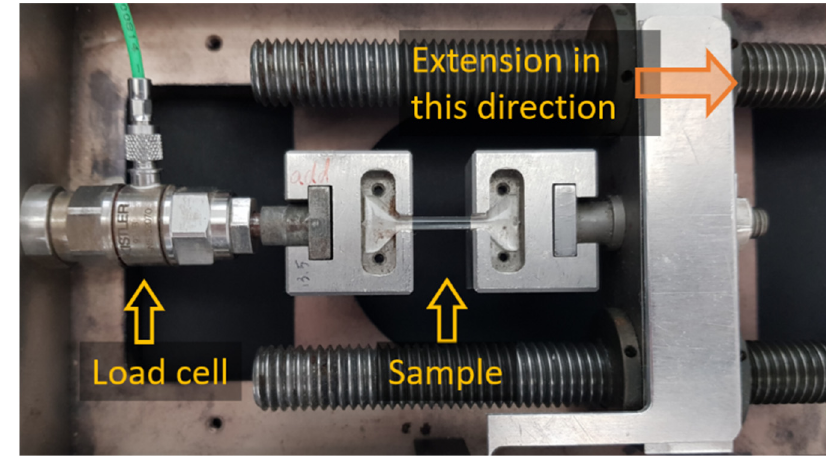
Figure 4. Set-up for single fibre fragmentation test.